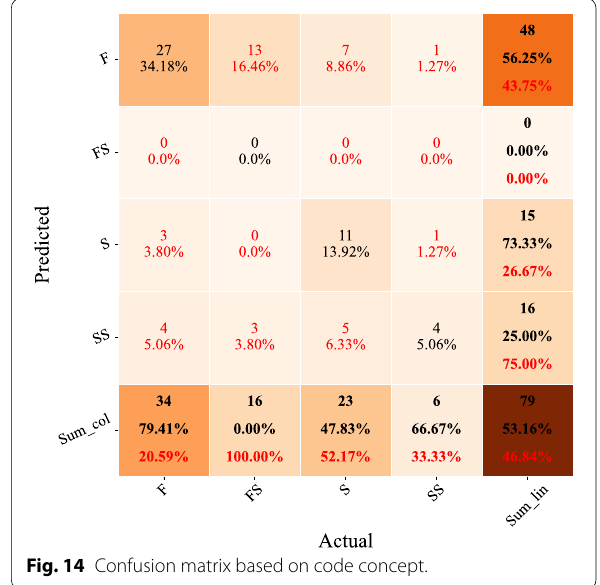
Fig. 14 Confusion matrix based on code